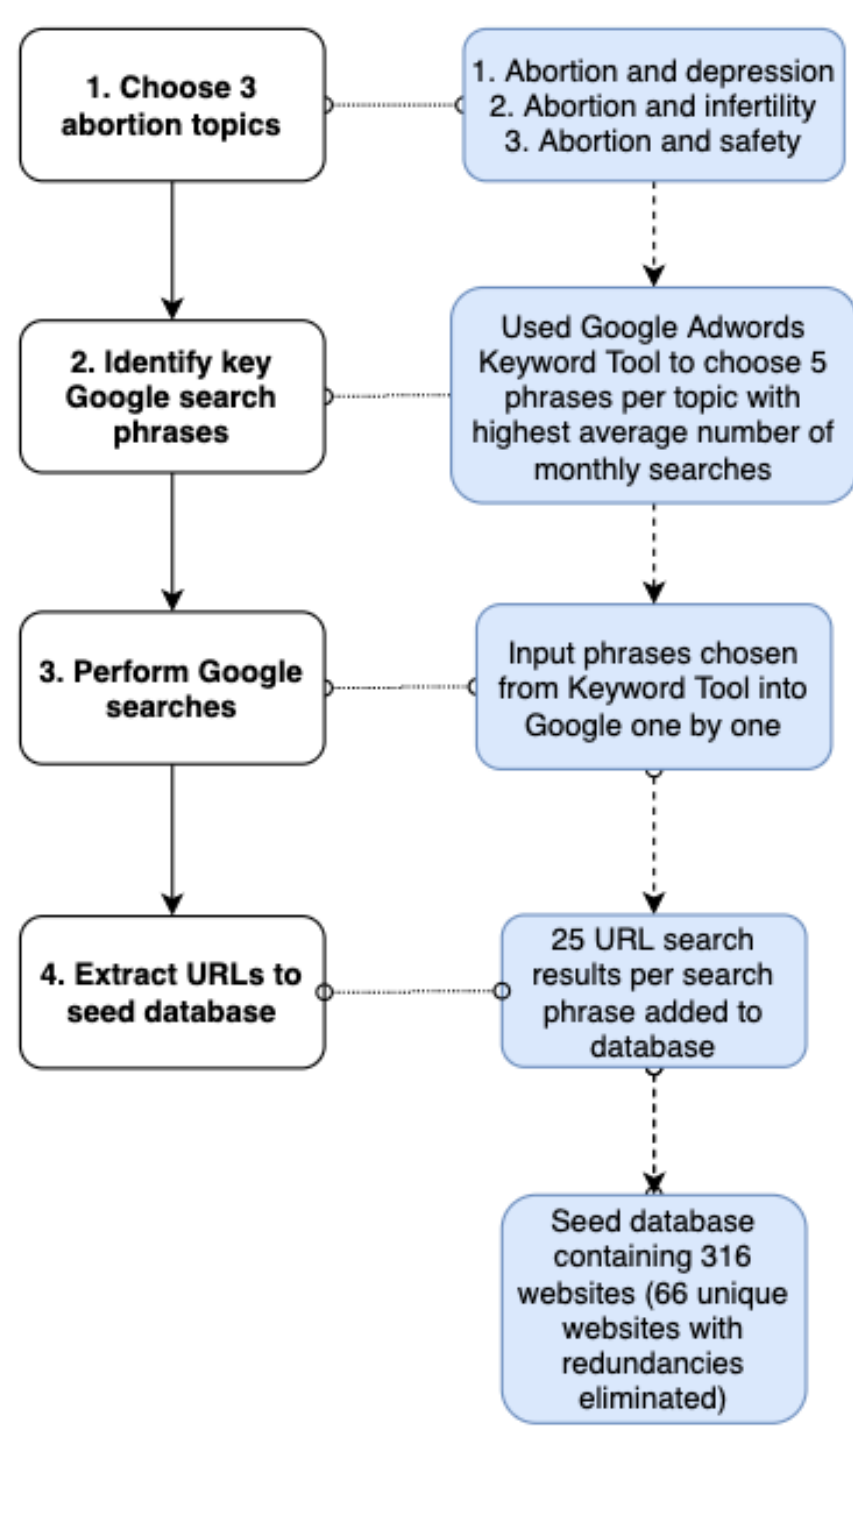
Figure 1. Workflow of website selection for the